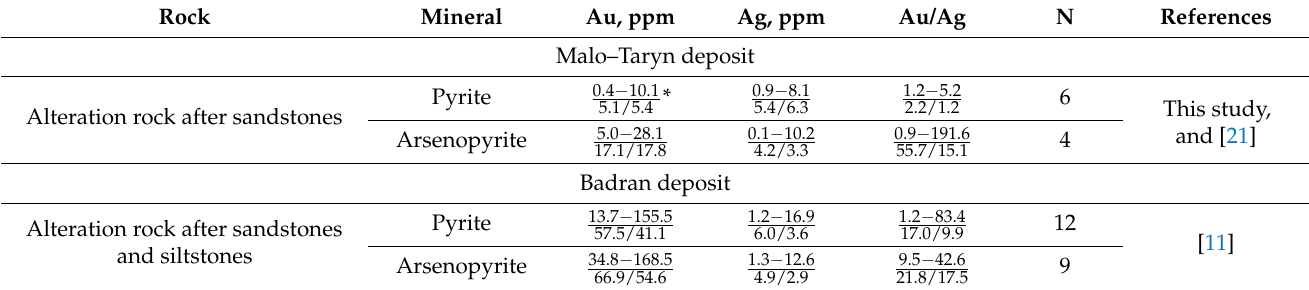
Table 4. Results of atomic absorption atomic spectrometry (ppm) of sulfides from the proximal alteration of the studied OGDs, central YKMB.